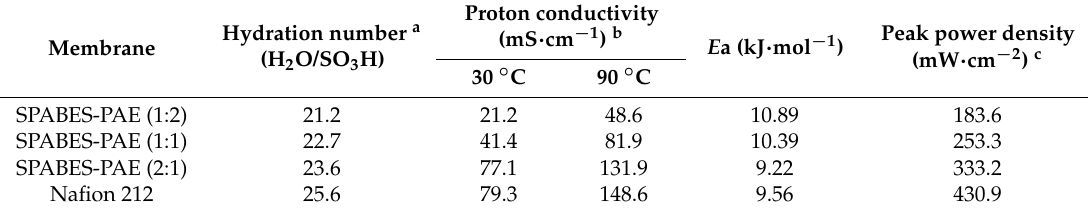
Figure 4. Proton conductivity of membranes at various temperature and 100% relative humidity (RH). Table 5. Hydration number, proton conductivity, activation energy ( E a ), and power density of SPABES-PAE and Nafion 212 membranes.